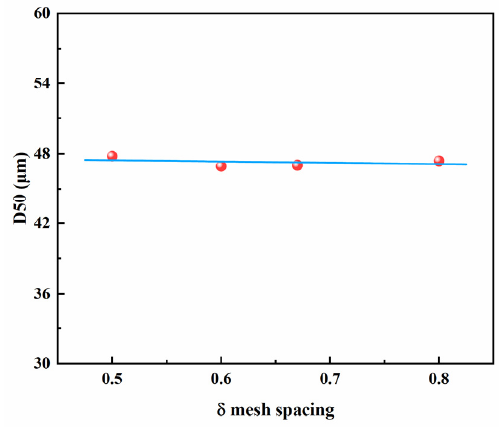
Figure 5. A plot of the effect of mesh spacing on the average mean diameter.